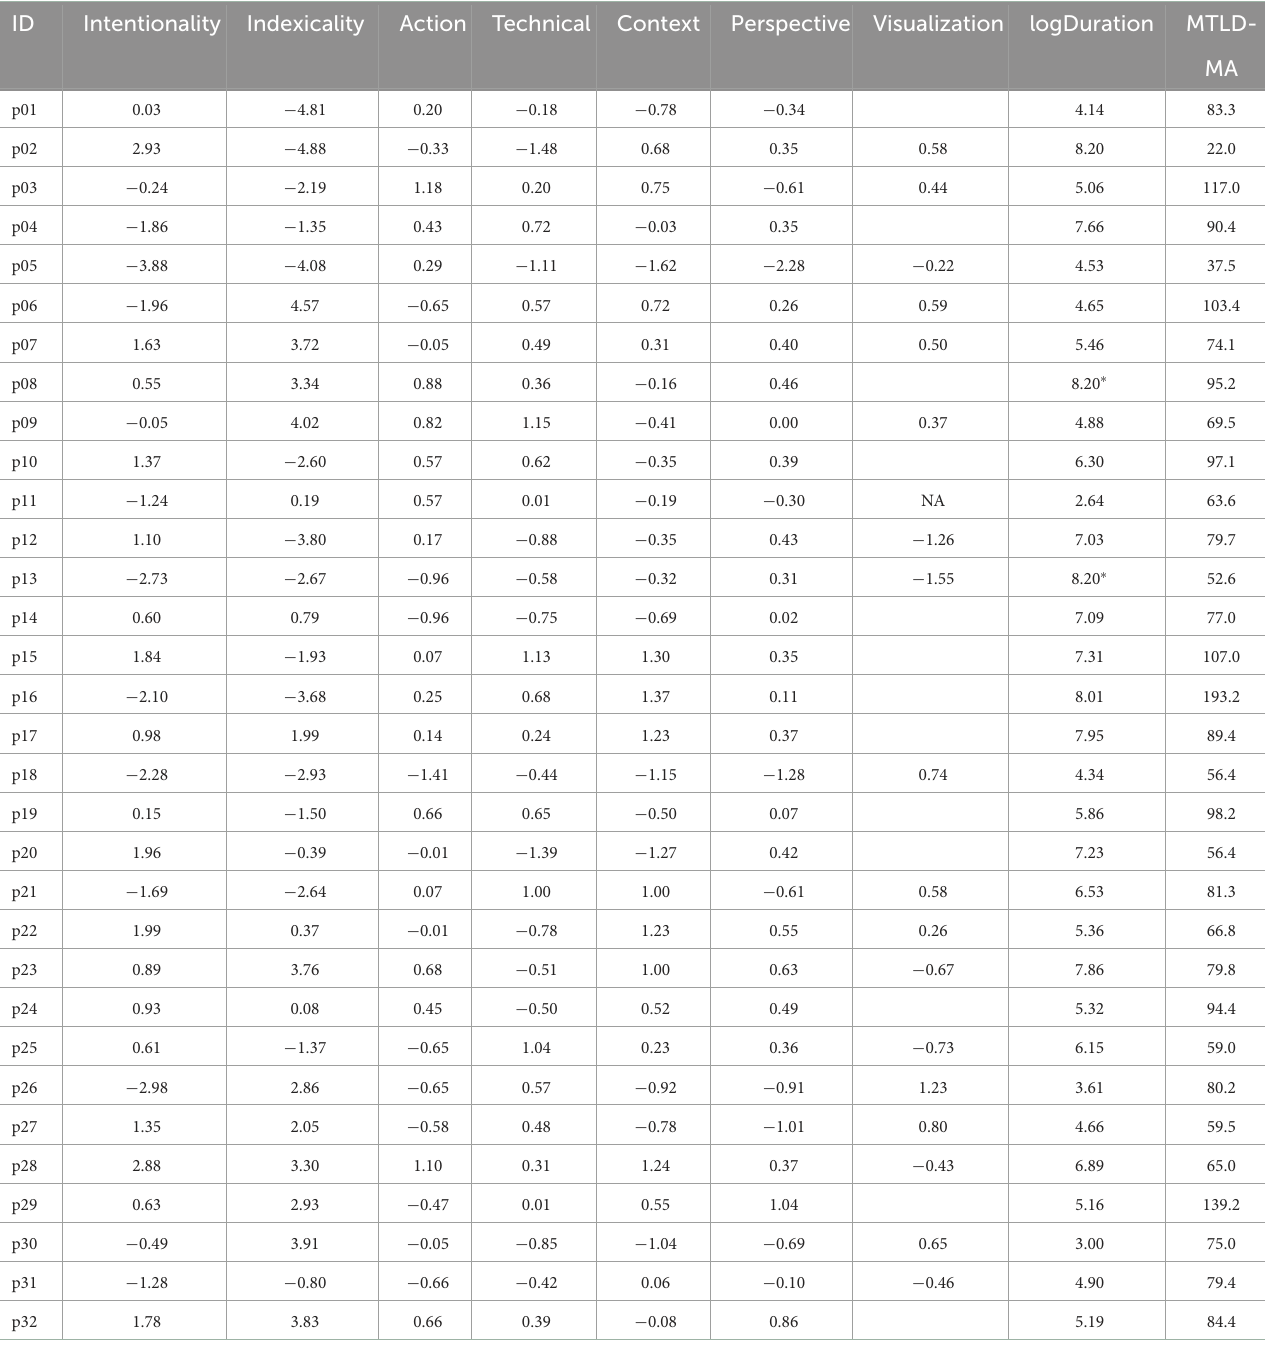
TABLE 2 Median scores for the 32 surveyed